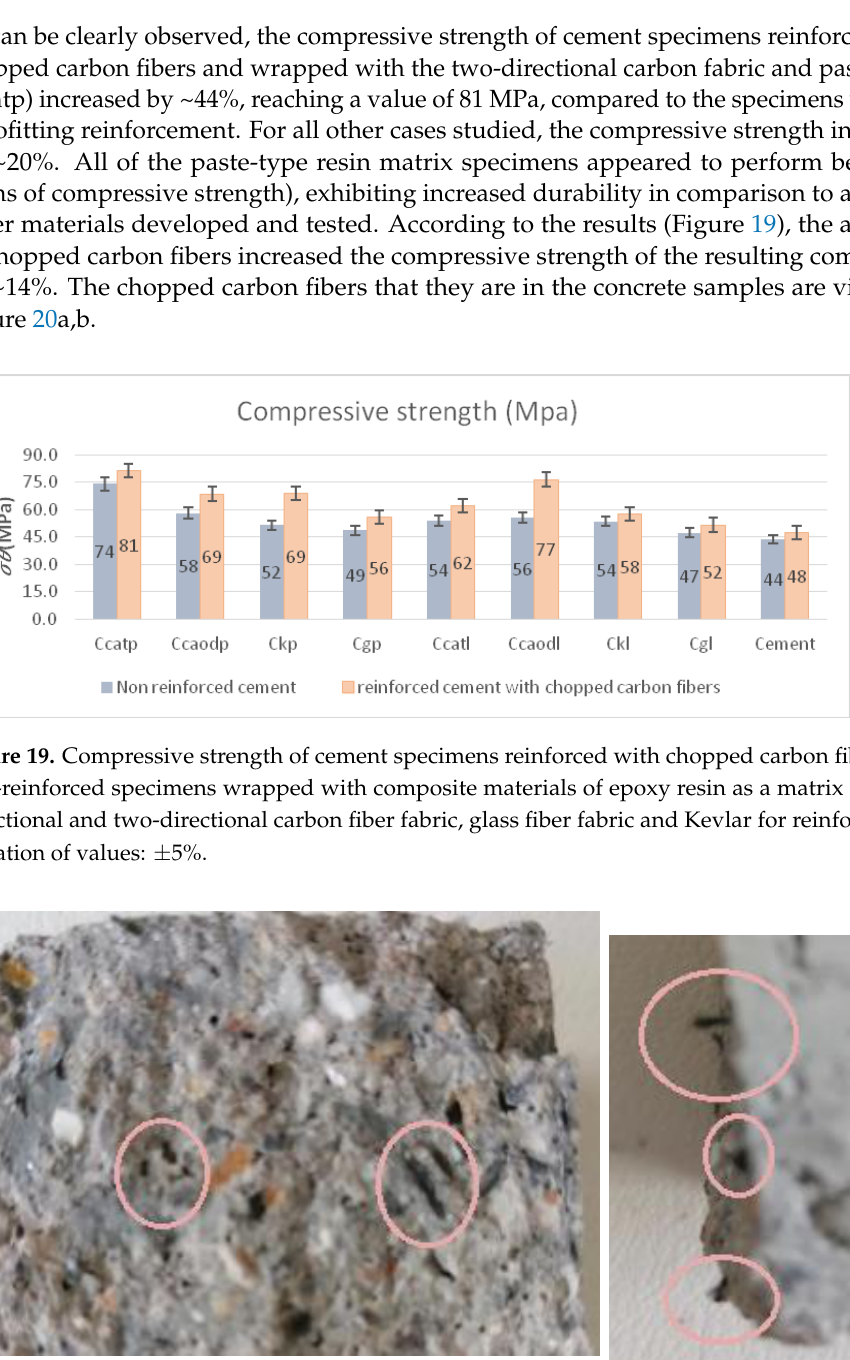
Figure 18. Compressed cement specimen without reinforcement (retrofitting).